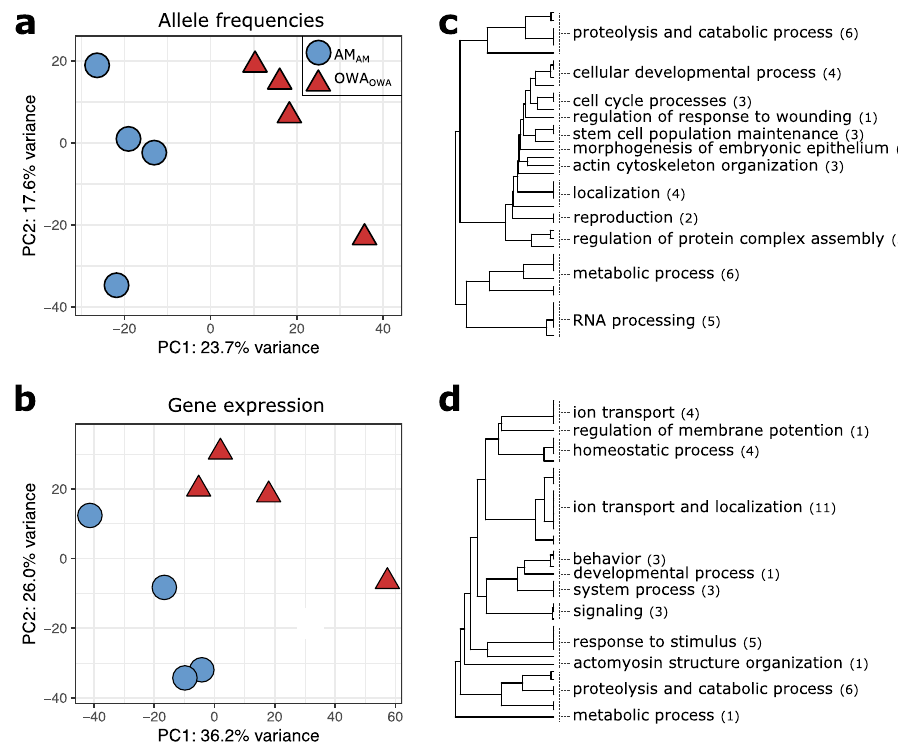
Fig. 2 Allele frequency and gene expression divergence after 20 generations of selection. Principal component analysis of ( a ) genome-wide variation in allele frequencies (322,595 SNPs) and ( b ) gene expression (24,927 genes) at the F1 generation. c , d Gene ontology enrichment results from one-sided Mann – Whitney U -test using P -values from Cochran – Mantel – Haenszel tests (allele frequencies, c ) and DESeq2 Wald tests (gene expression, d ). Gene categories are collapsed for visualization purposes with the number of categories indicated in parentheses. See Supplementary Data 3, 4 and Supplementary Figs. 9 and 10 for full results. Source data are provided as a Source Data fi